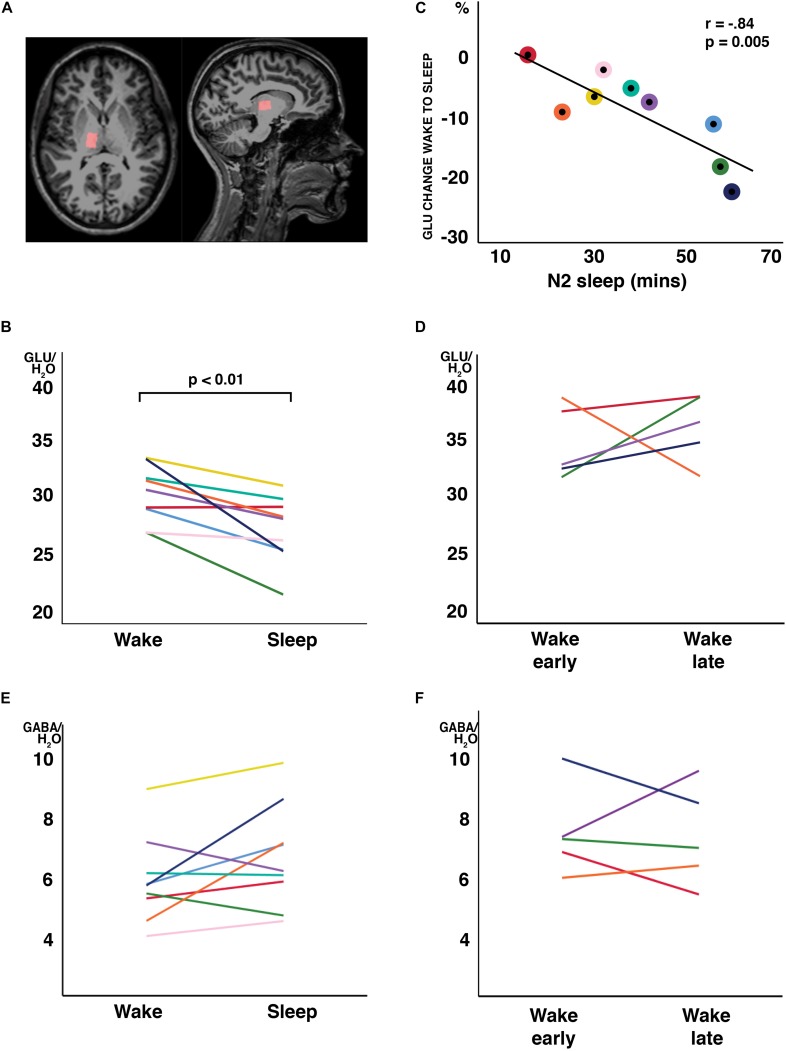
Changes in water-scaled glutamate (GLU) ratios from wakefulness to N2 sleep. (A) MR spectroscopy voxel placement in the thalamus. (B) GLU levels decreased from wakefulness to sleep in 8 of 9 study participants (arbitrary units; p < 0.01, two-tailed, paired t-tests) (C) The change from wakefulness to sleep was negatively correlated with N2 sleep duration. Individual participant’s data have the same color code in panels (B,C). (D) When a subset of participants stayed awake during an equivalent recording period at the same time of day, no changes in GLU were observed. No changes were observed in GABA ratios, neither from wakefulness to sleep (E) nor during the wake control condition (F). Each individual participant’s data have the same color code in panels (B–F).